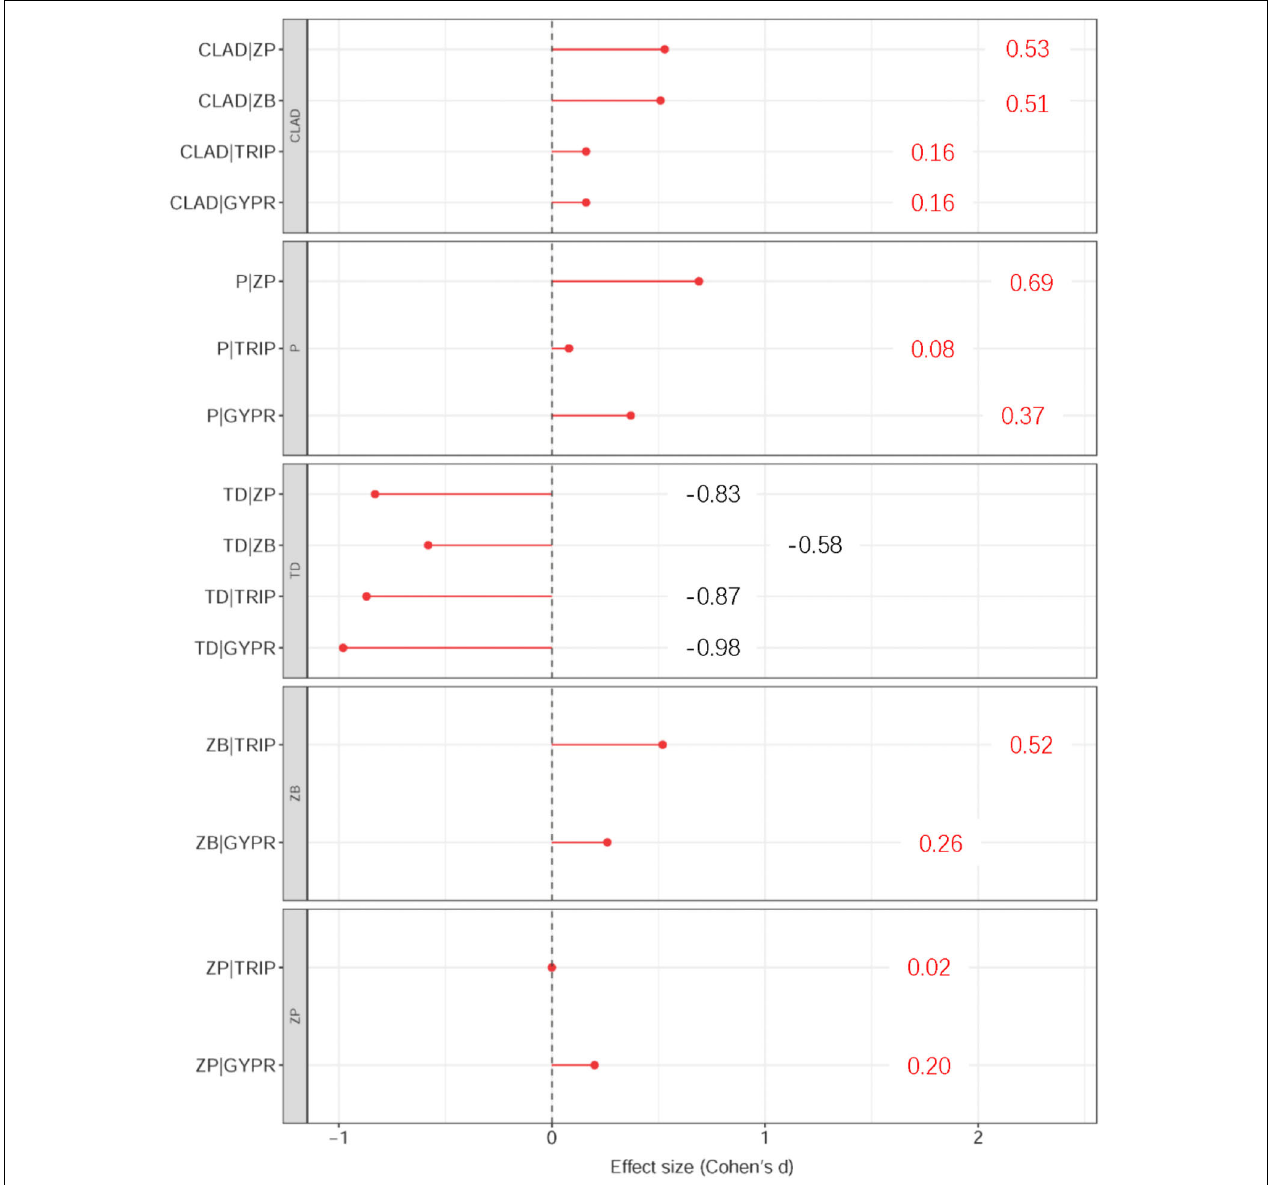
FIGURE 4 | Mean effect sizes of the difference in interaction strength of the same trophic links between the two habitats. Positive effects sizes indicate that the link is stronger in the new habitat whereas negative effect sizes indicate that the link is stronger in the original